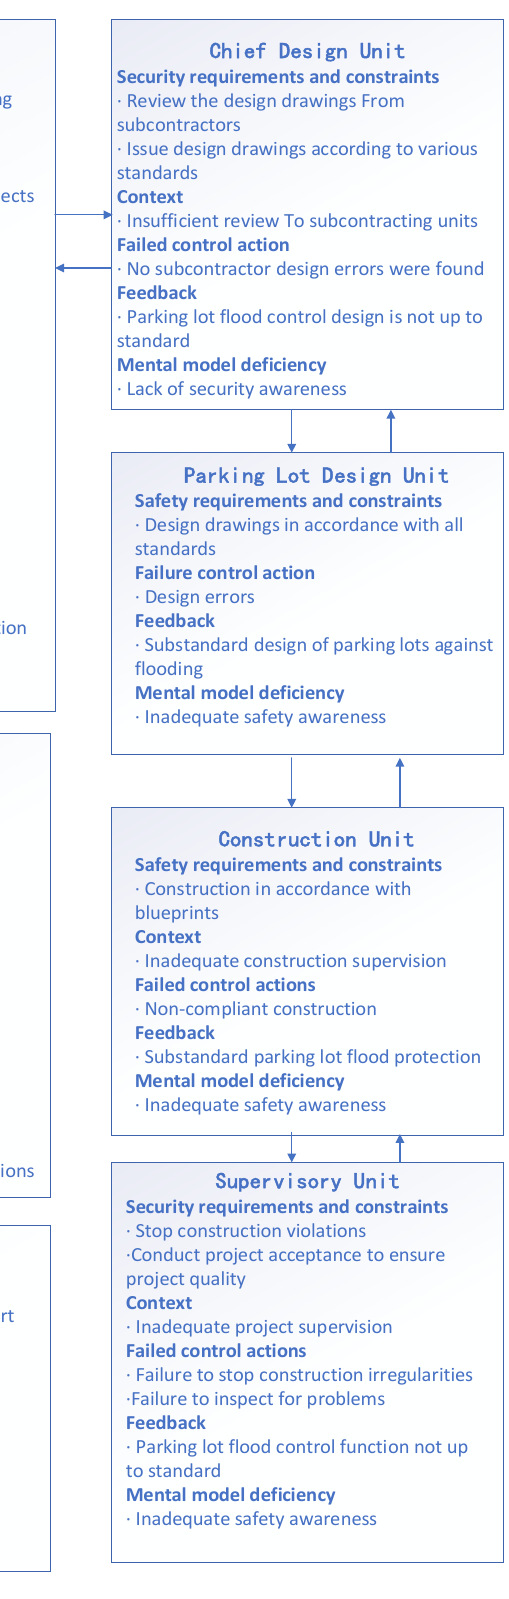
Figure 4. Zhengzhou Metro CAST Analysis.